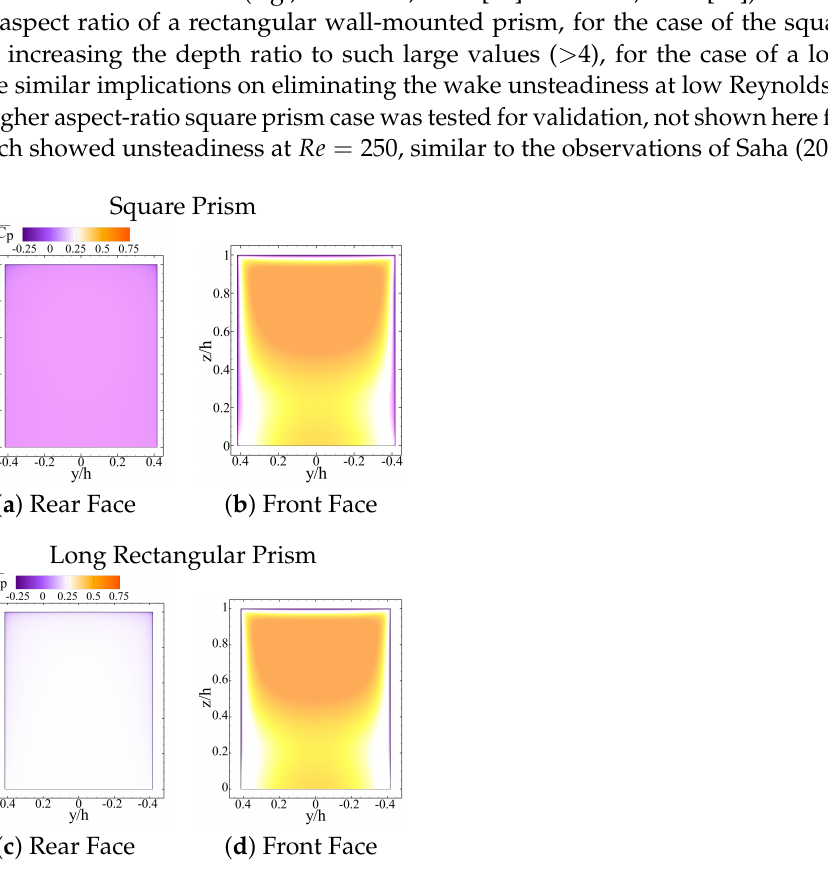
Figure 8. Distribution of C p on the rear and front faces of the ( a , b ) square and ( c , d ) long prism.